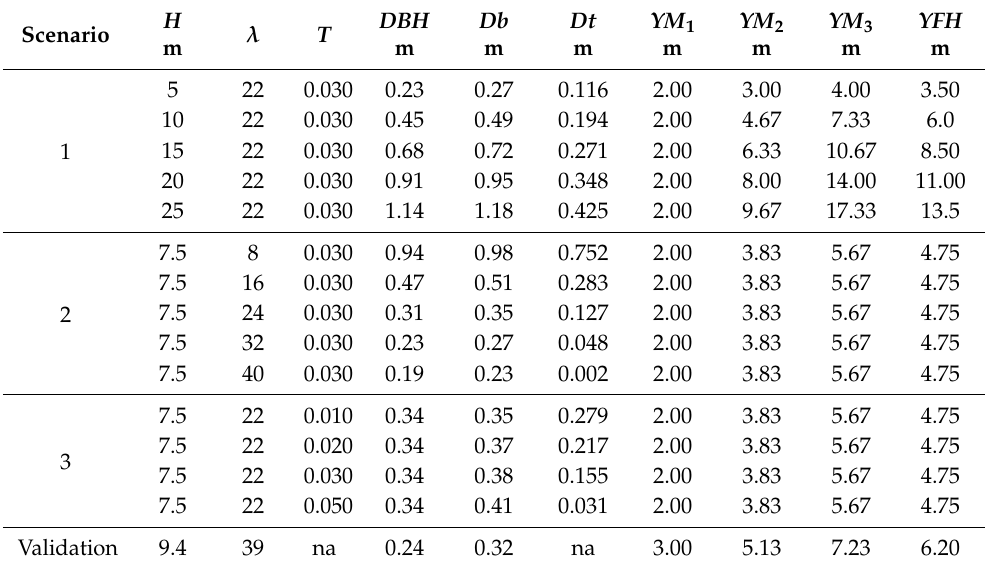
Table 1. Scenarios with total tree height ( H ), slenderness ( λ = H/DBH ), taper ( T = (Db-Dt)/H ), diameter at breast height ( DBH ), diameter at the base ( Db ) and at the top ( Dt ) of the trunk, and position ( Y ) of the moments ( YM 1 , YM 2 , YM 3 ) and of the horizontal forces ( YFH ) applied in the numerical simulations. Scenario